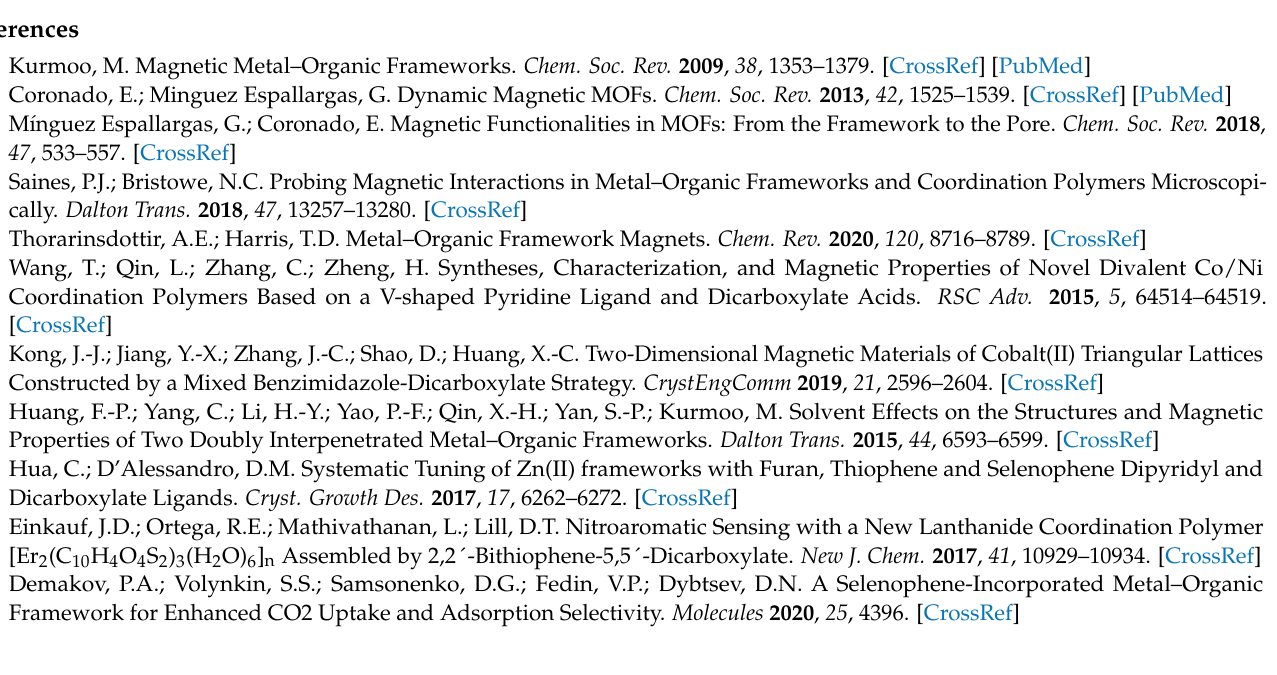
respectively); Figure S4: The IR spectrum of the compound 1 ; Figure S5: The IR spectrum of the compound 2 ; Table S2: Virial coefficients A i and B i for gas adsorption isotherms at 273 K and 298 K on 1 ; Figure S6: Semilogarithmic representation of nitrogen adsorption (filled squares) and desorption (open squares) isotherms at 77 K for the compound 1 ; Figure S7: Nitrogen adsorption isotherm fit (from pore size distrubution calculation); Figure S8: Pore size distributions for 1 calculated by DFT (N 2 adsorption at 77 K) and Zeo++ [1,2]; Figure S9: Fits of isotherms by virial equations; Figure S10: Isosteric heats of gas adsorption on 1 ; Table S3: Henry constants for gas adsorption on 1 in mmol · g − 1 · bar − 1 at 273 K and 298 K; Table S4: Fitted parameters for adsorption isotherms on 1 at 273 K and 298 K; Figure S11: Fits of the gas adsorption isotherms by appropriate models; Figure S12: Prediction of adsorption equilibrium by IAST (solid lines) and dependence of selectivity factors on gas phase composition (dashed lines) for binary gas mixtures: (a) CO 2 /N 2 ; (b) CO 2 /CH 4 ; (c) CO 2 /O 2 ; (d) CO 2 /CO; Figure S13: Temperature dependences of the magnetic susceptibility for compounds 1 (left) and 2 (right). The magnetic susceptibility of both compounds exhibits dependence neither on magneto-thermal history, nor on the magnetic field value, except for the lowest temperatures where the curves measured at 1 and 10 kOe diverge slightly due to nonlinear M(H)